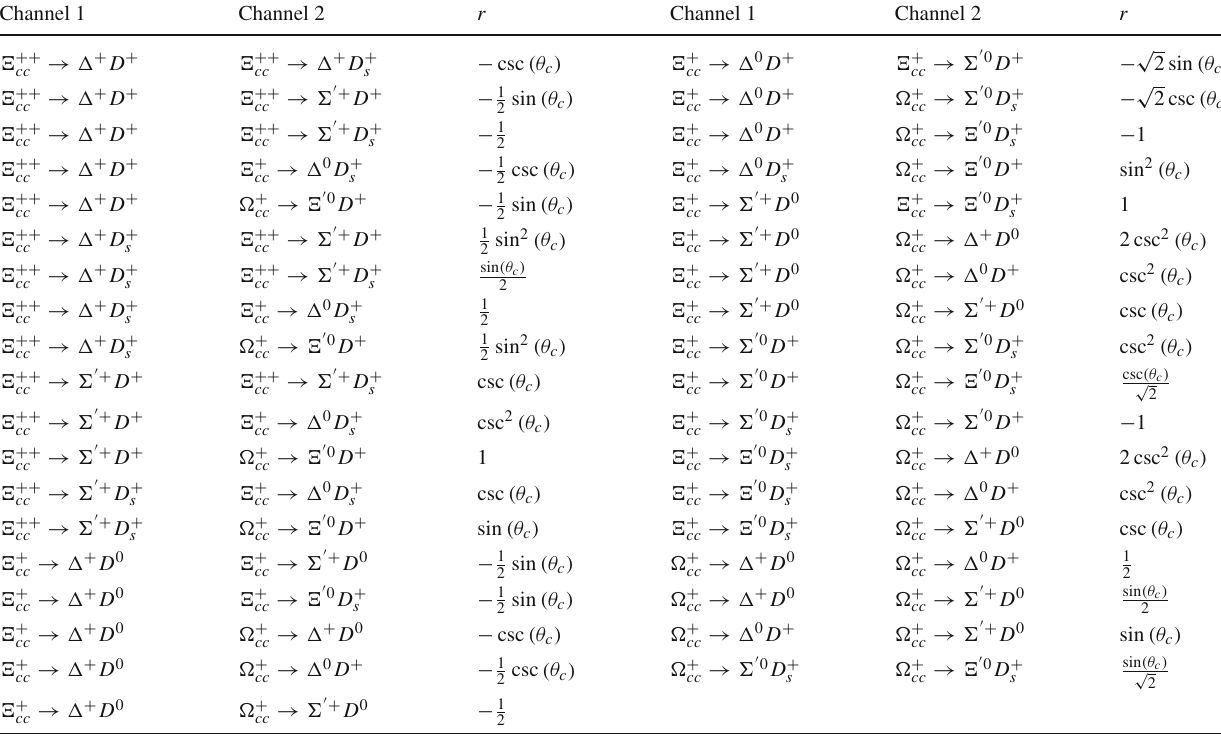
Table 11 Decay width relations for Cabibbo-allowed, singly Cabibbo-suppressed and doubly Cabibbo-suppressed processes in Table 8 Channel